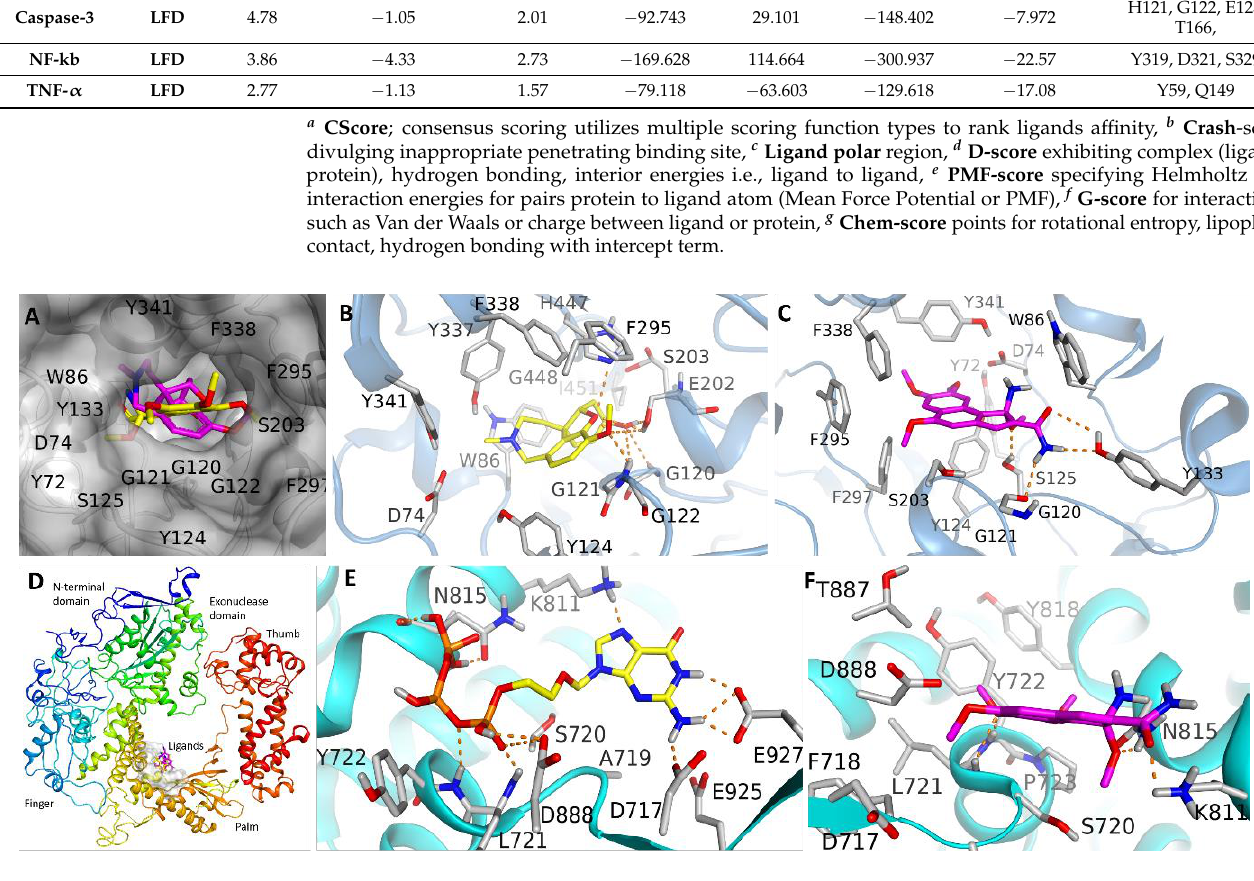
Figure 5. Comparison of binding mode of tested compound LFD with the standard compounds Galantamine (GLM) and Acyclovir (ACV) bind to their respective targets. ( A ) LFD (magenta) and GLM (yellow) superposed in the same binding cavity of AChE enzyme. Best docking generated poses of selected ligands in AChE ( B ) GLM-AChE and ( C ) LFD-AChE. Superposition of LFD (magenta) and ACV (yellow). ( D ) Overall atomic model of LFD ( E and F ) ACV and LFD bonded to DNA-POL, respectively. Predicted bonding interactions of hydrogen illustrated in dashed lines (yellow).